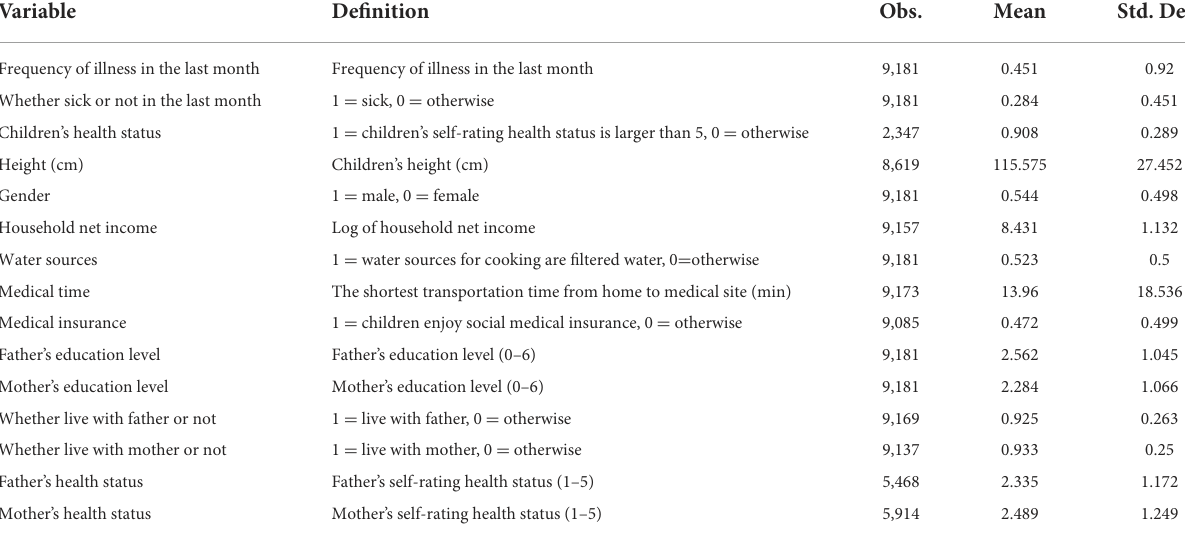
TABLE 2 Summary statistics.